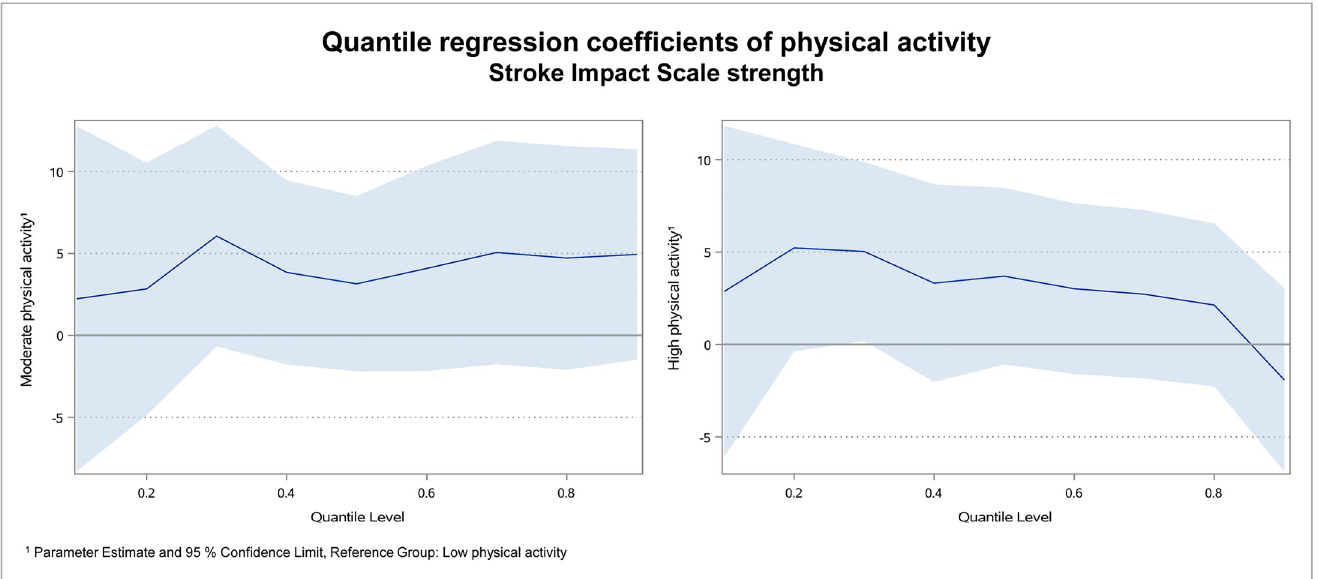
Fig 2 illustrates the regression coefficients of physical activity for SIS strength per quantile. In the subdomain strength, the coefficient of moderate physical activity was the lowest at quantile 0.1 (2.2). Afterwards it raised and reached its peak at quantile 0.3 (6.1). In the quan- tiles 0.4 to 0.9 it was varying between 3.2 and 5.1. In the group of high physical activity, the lowest coefficient was -1.9 in quantile 0.9.